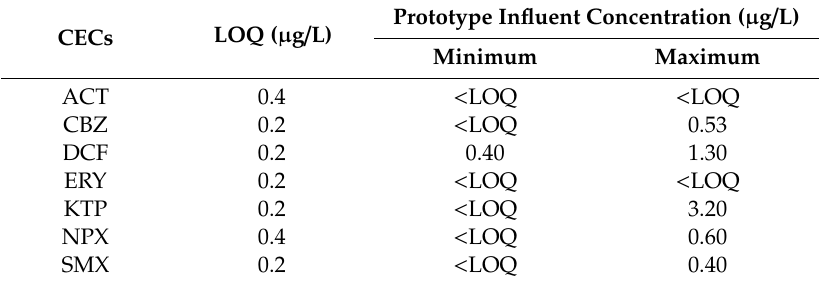
Table 6. CECs concentration in the prototype influent. LOQ ( µ g /